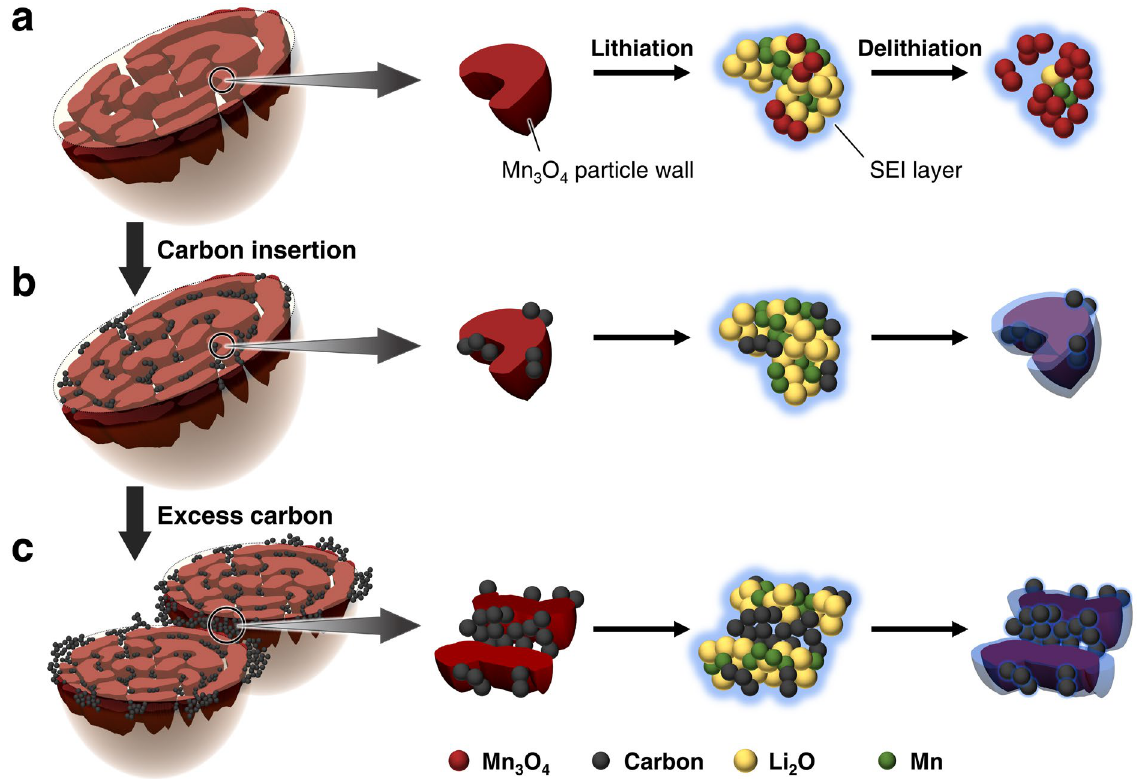
Figure 9. Illustration of the conversion reaction of the ( a ) bare Mn 3 O 4 , ( b ) Mn 3 O 4 /C composite, and ( c ) composite with an excess amount of carbon during the charge–discharge